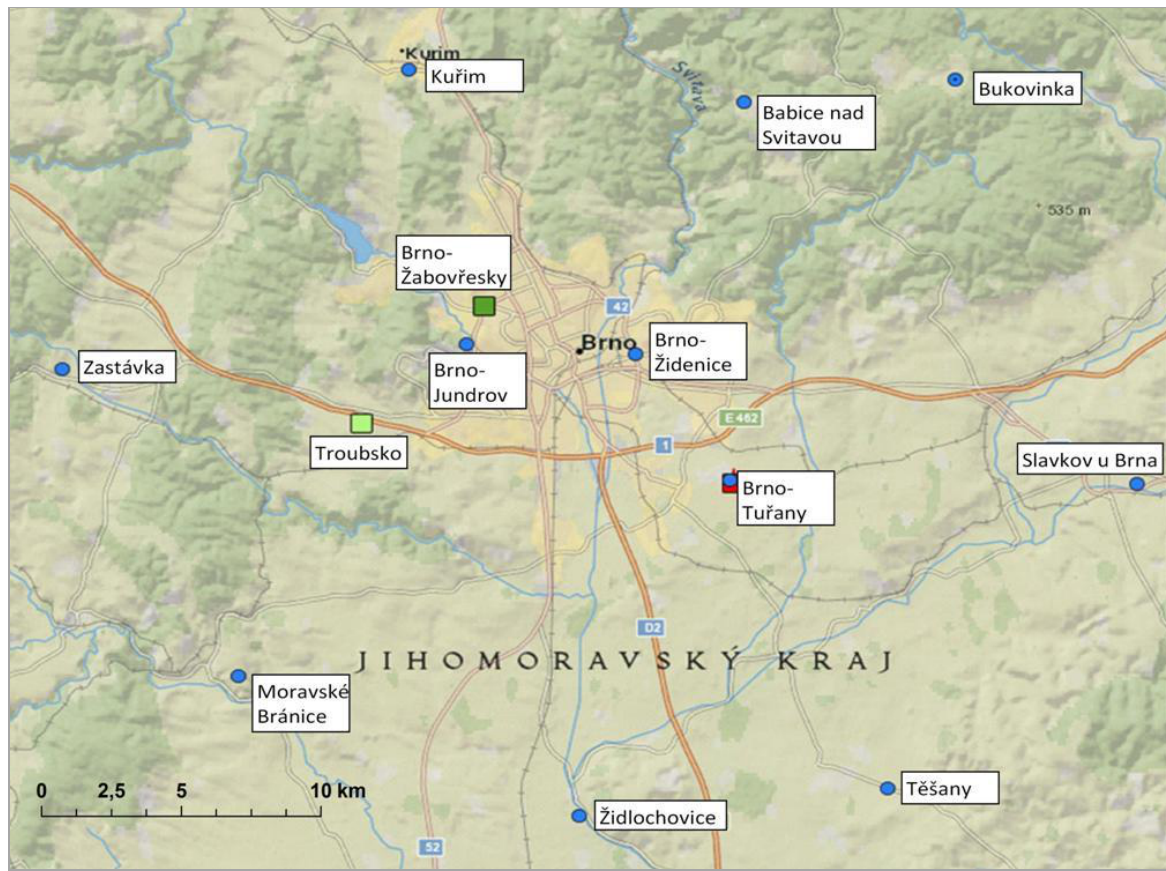
Fig. 1. Meteorological stations used in the